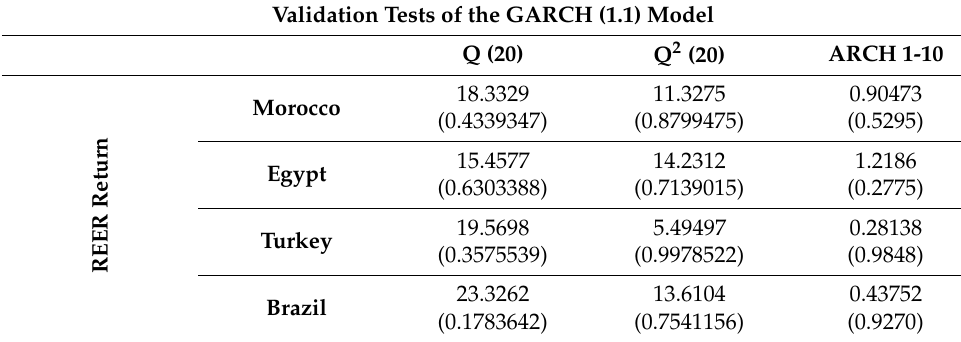
Table 6. Validation tests of the GARCH